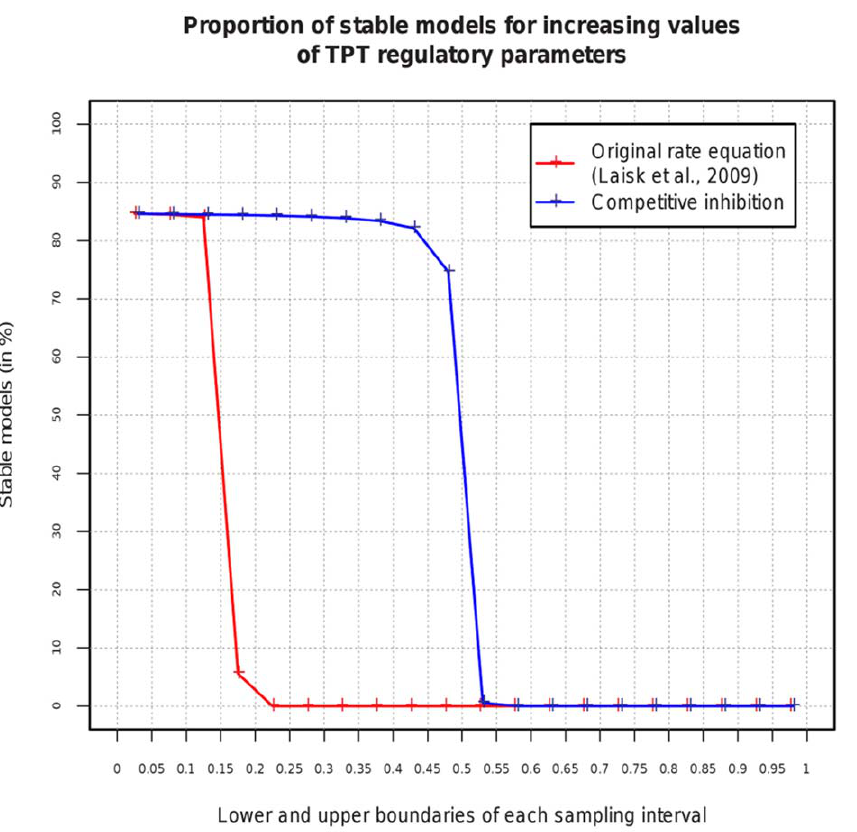
Figure 4. Stable steady states for increasing values of regulatory TPT parameters. Effect of increasing SK-model parameters for the triose- phosphate translocator (TPT) under different assumptions regarding regulatory mechanisms. Transporter-associated model parameters were sampled from consecutive intervals of length 0.1. For each interval, 10 5 SK-models were generated.